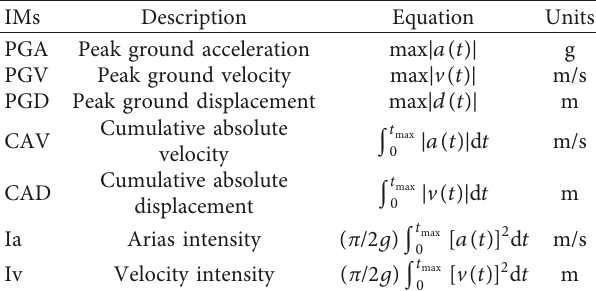
Table 1: List of intensity measures compared in this